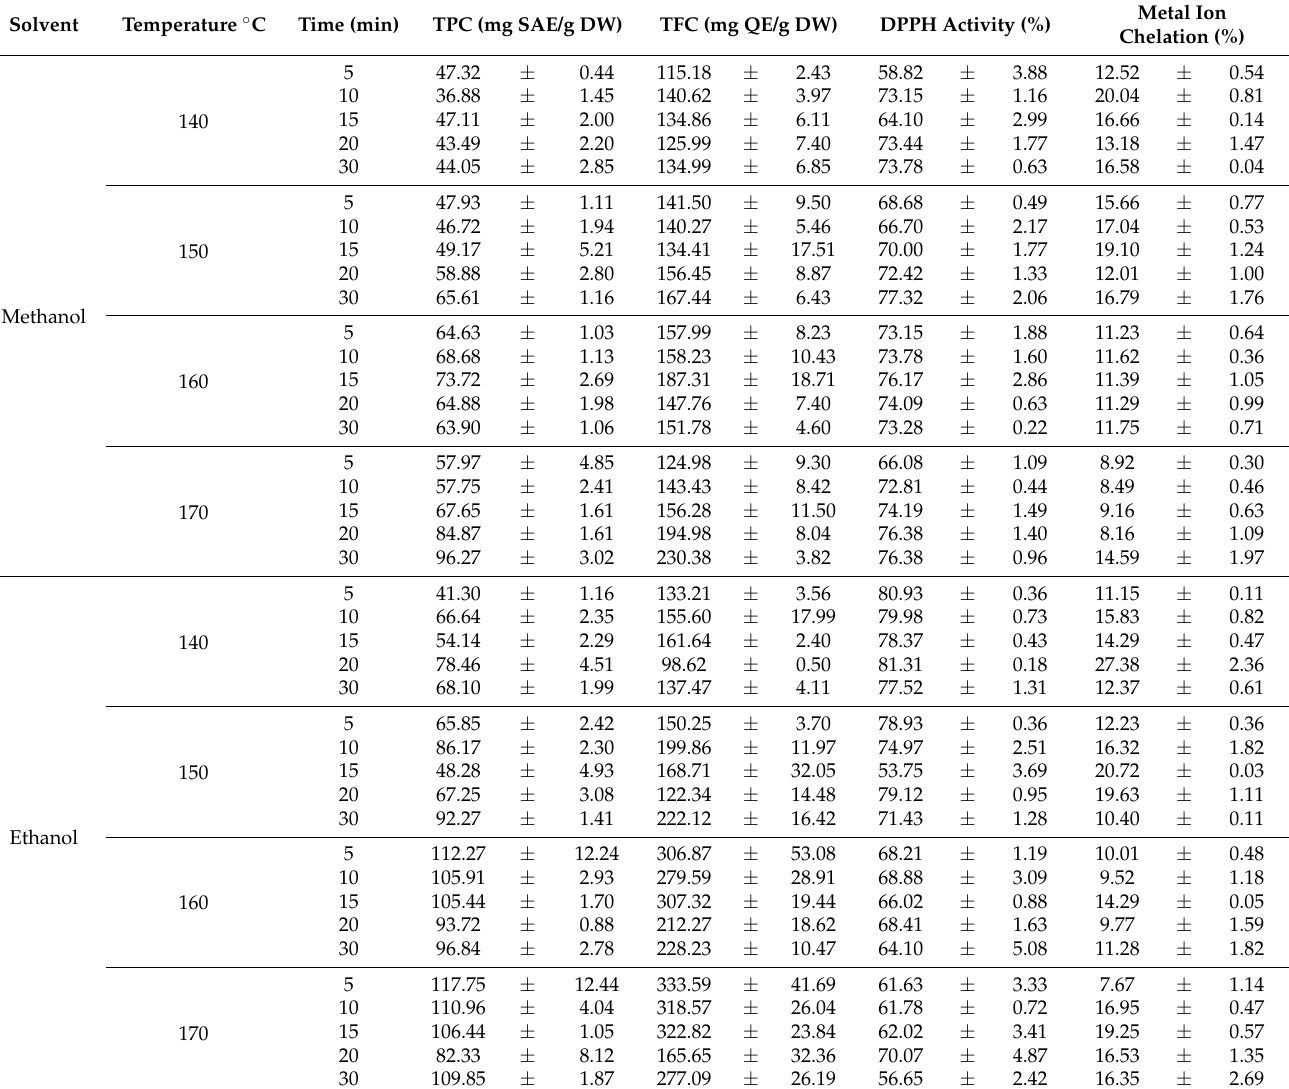
Table 4. Assessment of the total phenolic content (TPC)/total flavonoid content (TFC) and antioxi- dant